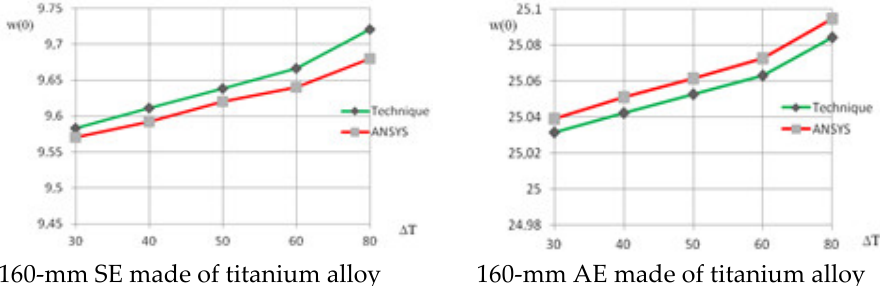
Figure 17. Thermal patterns of electrodes in the ANSYS software.